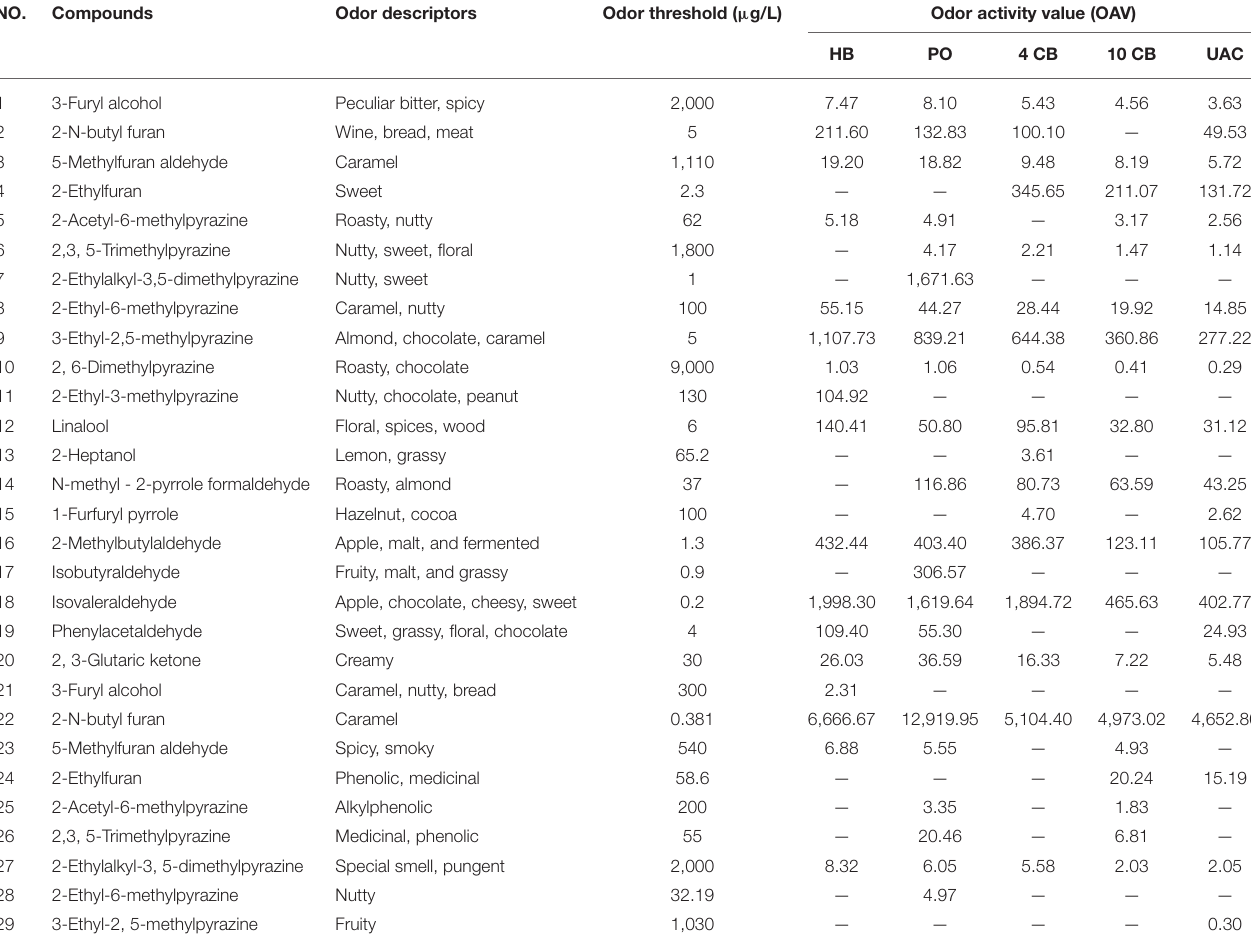
TABLE 4 | Odor thresholds and odor activity values (OAVs) of potent volatile compounds in coffee extracts with different brewing methods. NO.